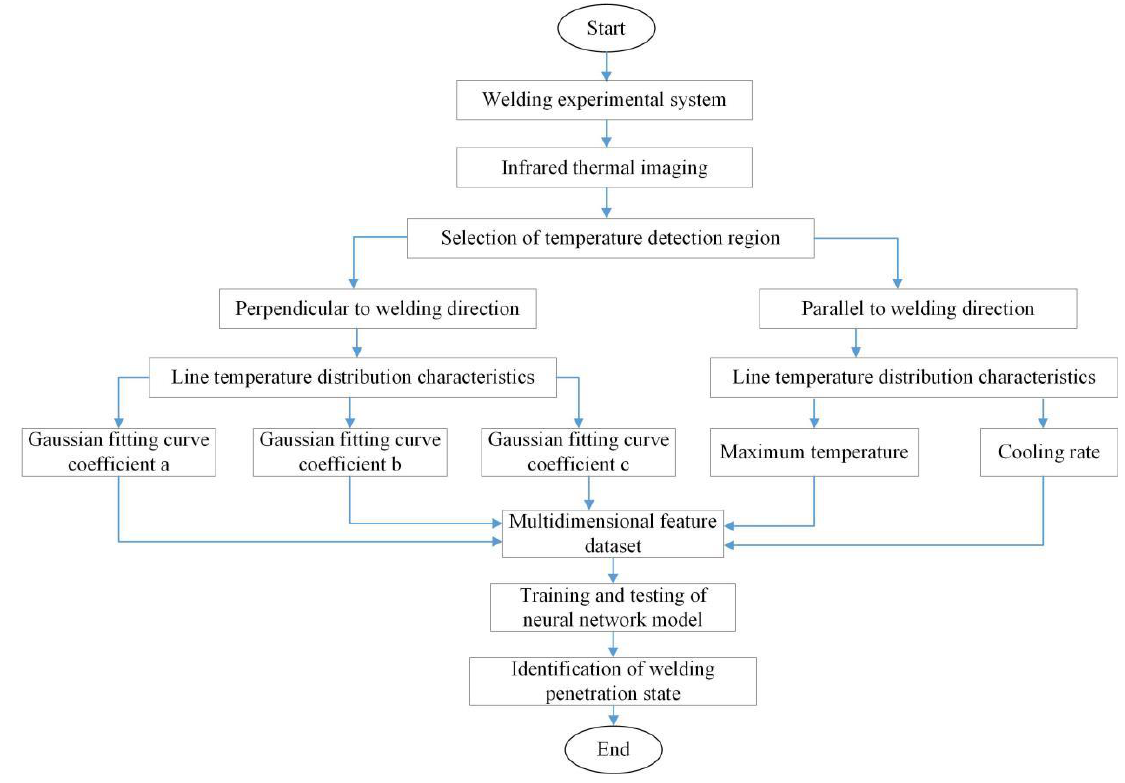
Figure 8. Flow chart of the proposed penetration sensing method.